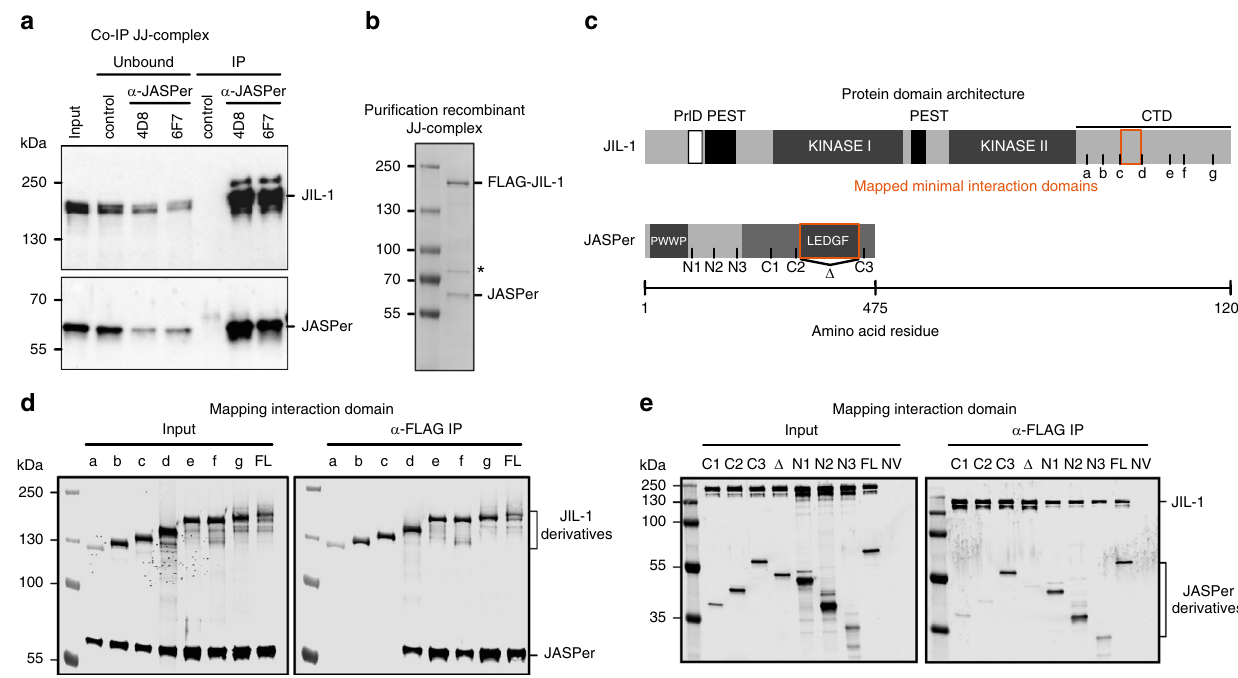
Fig. 1 JIL-1 ’ s C-terminal domain interacts with JASPer ’ s LEDGF domain to form the JJ-complex. a Western blot analysis with α -JASPer and α -JIL-1 antibodies of co-IP from nuclear embryo extracts. Co-IP was performed with two different monoclonal α -JASPer antibodies containing culture supernatants and culture medium as control. The corresponding unbound fractions are loaded next to each IP. Molecular weight markers are shown to the left. Source data are provided as a Source Data fi le. b SDS-PAGE with Coomassie staining of recombinant JJ-complex puri fi cation from Sf21 cells using a baculovirus dual expression system of FLAG-JIL-1 and untagged JASPer. Molecular weight markers are shown to the left. A contaminant band is marked by asterisk. Source data are provided as a Source Data fi le. c JIL-1 and JASPer domain architecture drawn to scale. In JIL-1, PEST domains are highlighted in black, kinase domains in dark gray and a predicted prion-like domain in white. In JASPer, PWWP and LEDGF domains are highlighted in dark gray and conserved region in intermediate gray. C-terminal truncation breakpoints a – g for JIL-1 and N-terminal (N1-N3) and C-terminal truncation breakpoints (C1-C3) for JASPer used in d and e are indicated. Δ denotes the deletion in JASPer- Δ LEDGF. d Western blot analysis using α -JIL-1 and α -JASPer antibodies of co-IP experiments with extracts from Sf21 cells expressing wild type, untagged JASPer and various FLAG-JIL-1 C-terminal deletion mutants. Co-IP was performed with α -FLAG beads. Source data are provided as a Source Data fi le. e Western blot analysis as in d of co-IP experiments with extracts from Sf21 cells expressing various untagged JASPer deletion mutants and FLAG-JIL-1. Uninfected Sf21 cell extract was used as control (NV = no virus). Co-IP was performed with α -FLAG beads. Source data are provided as a Source Data fi